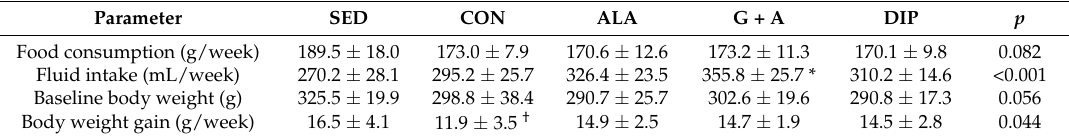
Table 1. Food consumption, fluid intake and body weight gain.